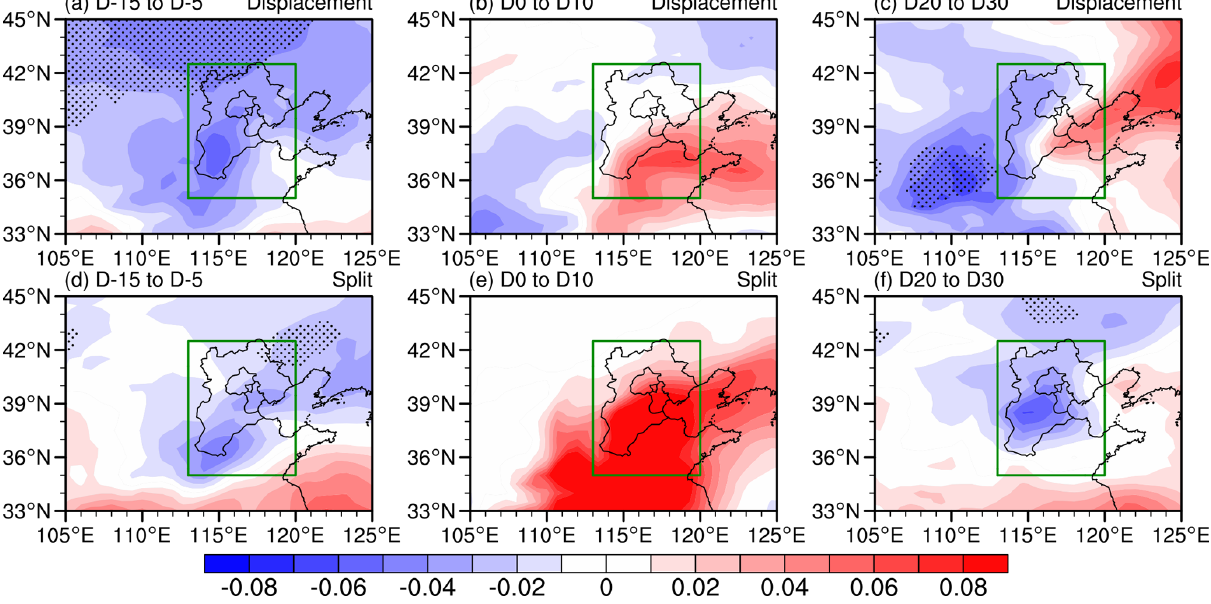
Figure 8. Composite analysis of the aerosol optical depth (AOD) anomalies in the BTH region during three periods of the SSW for vortex displacement events (a–c) and vortex split events (d–f) . (a, d) Day − 15 to day − 5 in the pre-SSW period. (b, e) Day 0 to day 10 in the SSW onset period and afterwards. (c, f) Day 20 to day 30 in the SSW decaying period. The dotted regions mark the composite AOD anomalies at the 90% confidence level based on the two-sided Student’s t test. The green box marks the focused BTH